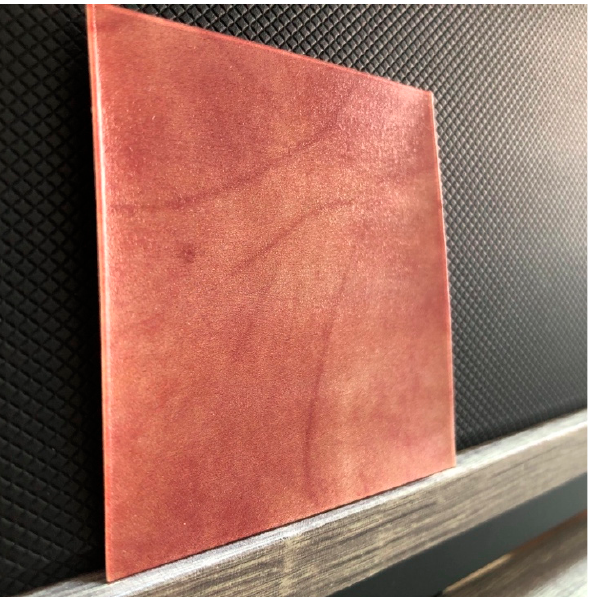
Figure 10. The fabrication result using multiple regression analysis.